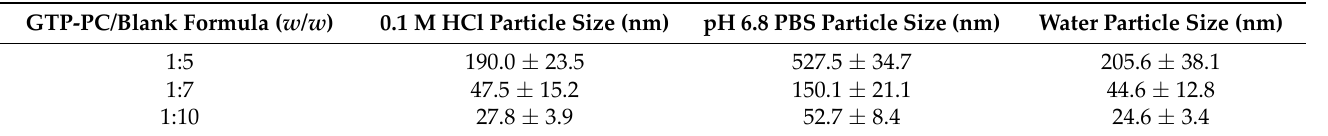
Table 6. The particle size of GTP‑PC‑SNEDDS with different ratios of drug/blank formula ( w / w ) in 0.1 M HCl, pH 6.8 PBS, and water (nm).